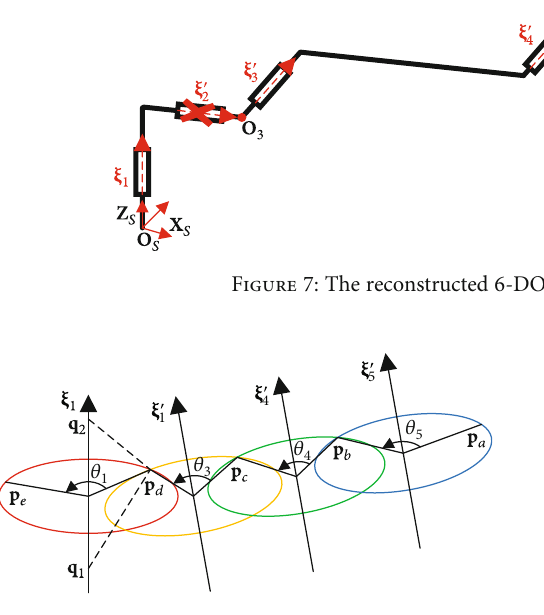
Figure 8: The screw motion of joints 1, 3, 4, and 5.